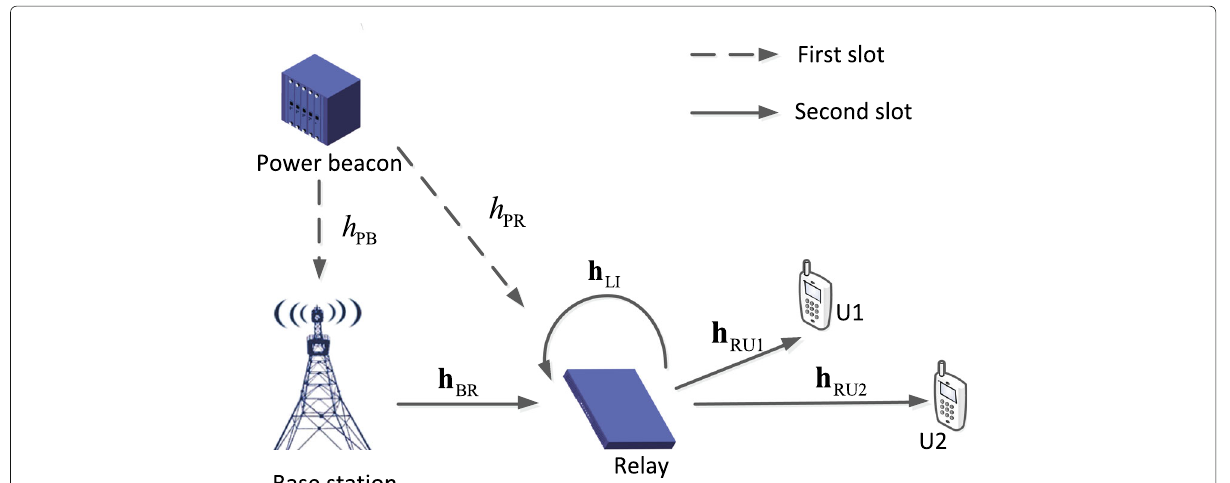
Fig. 1 Power beacon-assisted NOMA system with full-duplex